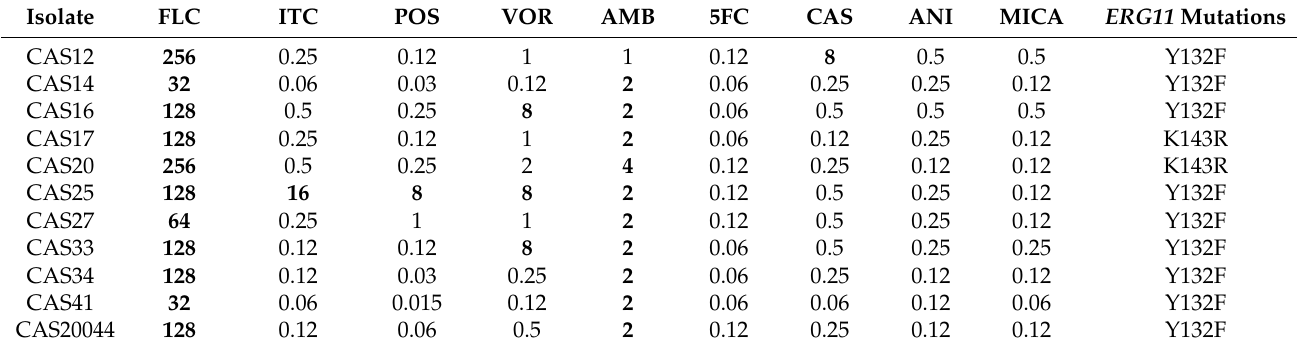
Table 2. In vitro susceptibility to nine antifungal agents and ERG11 mutations in selected C. auris isolates. Elevated minimum inhibitory concentration (MIC) values are bold. AMB = amphotericin B; 5FC = flucytosine, CAS = caspofungin, FLC = fluconazole, ITC = itraconazole, VOR = voriconazole, POS = posaconazole, ANI = anidulafungin, and MICA =